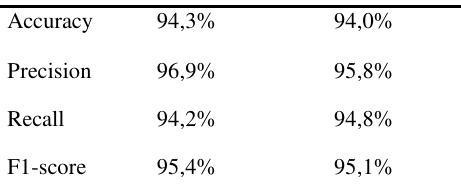
Table 1. Validation measures with different shares of training data